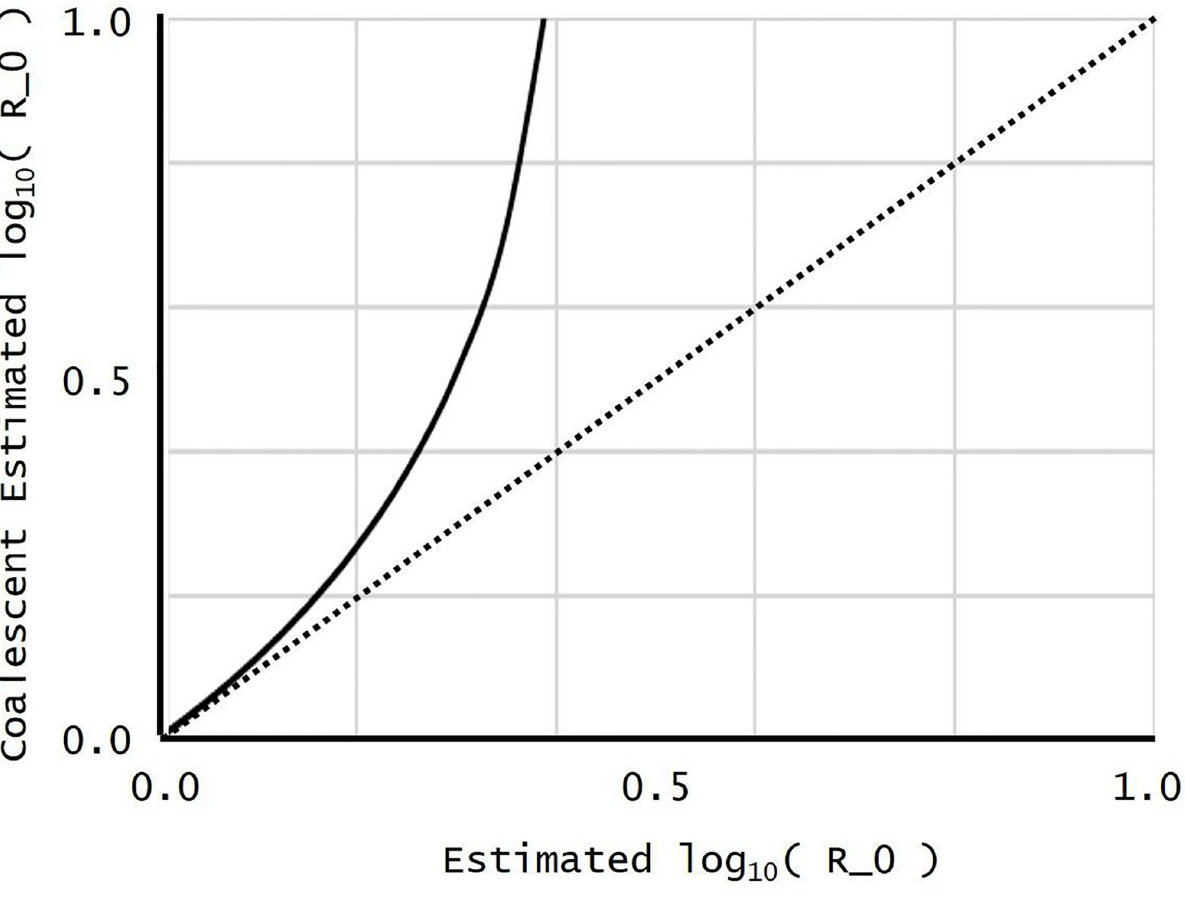
Fig 3. A plot of ^ r ð C Þ against ^ r ð I Þ